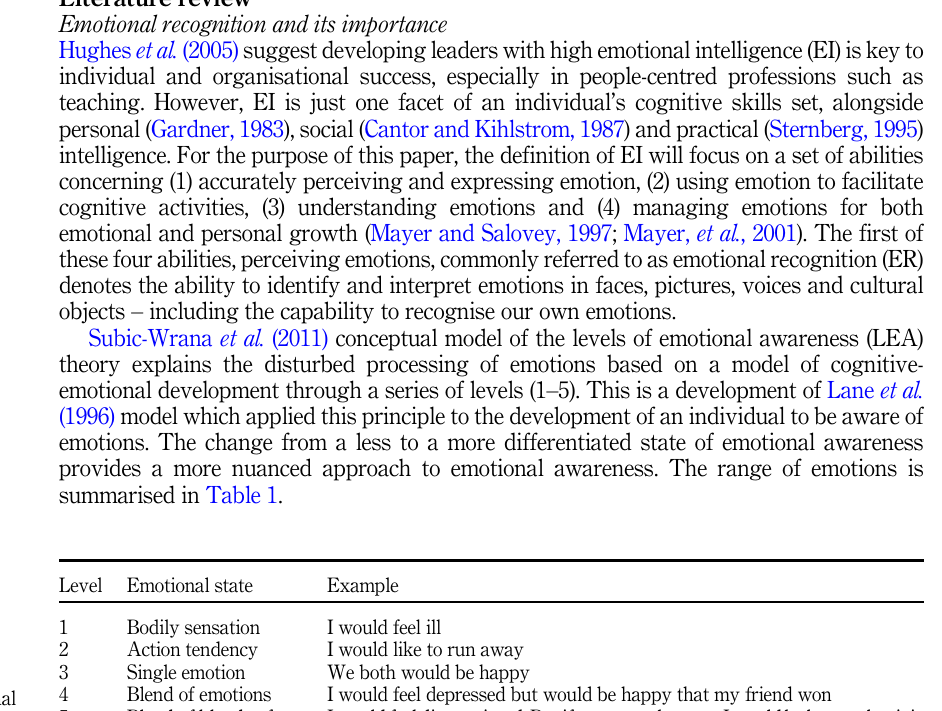
awareness based on Lane et al.